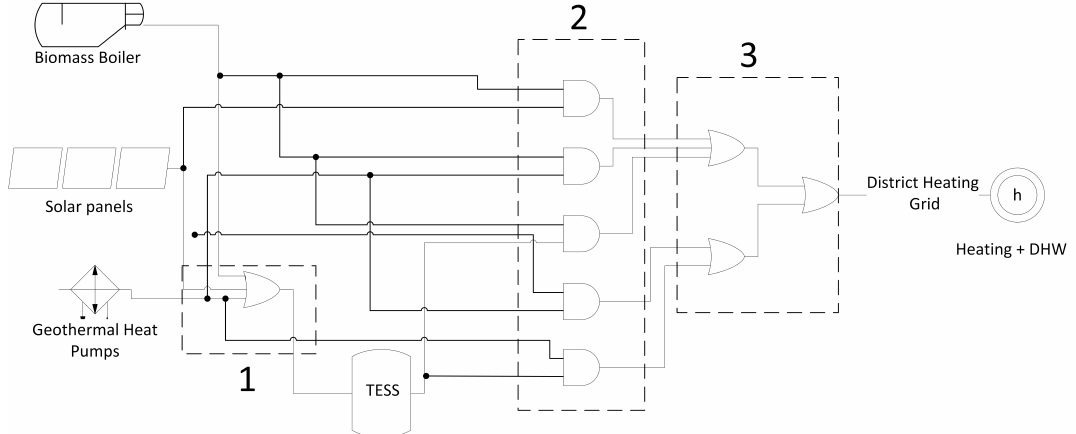
Figure 7. Expanded P-graph including the equipment to be used and logic gate numeration, for the heating